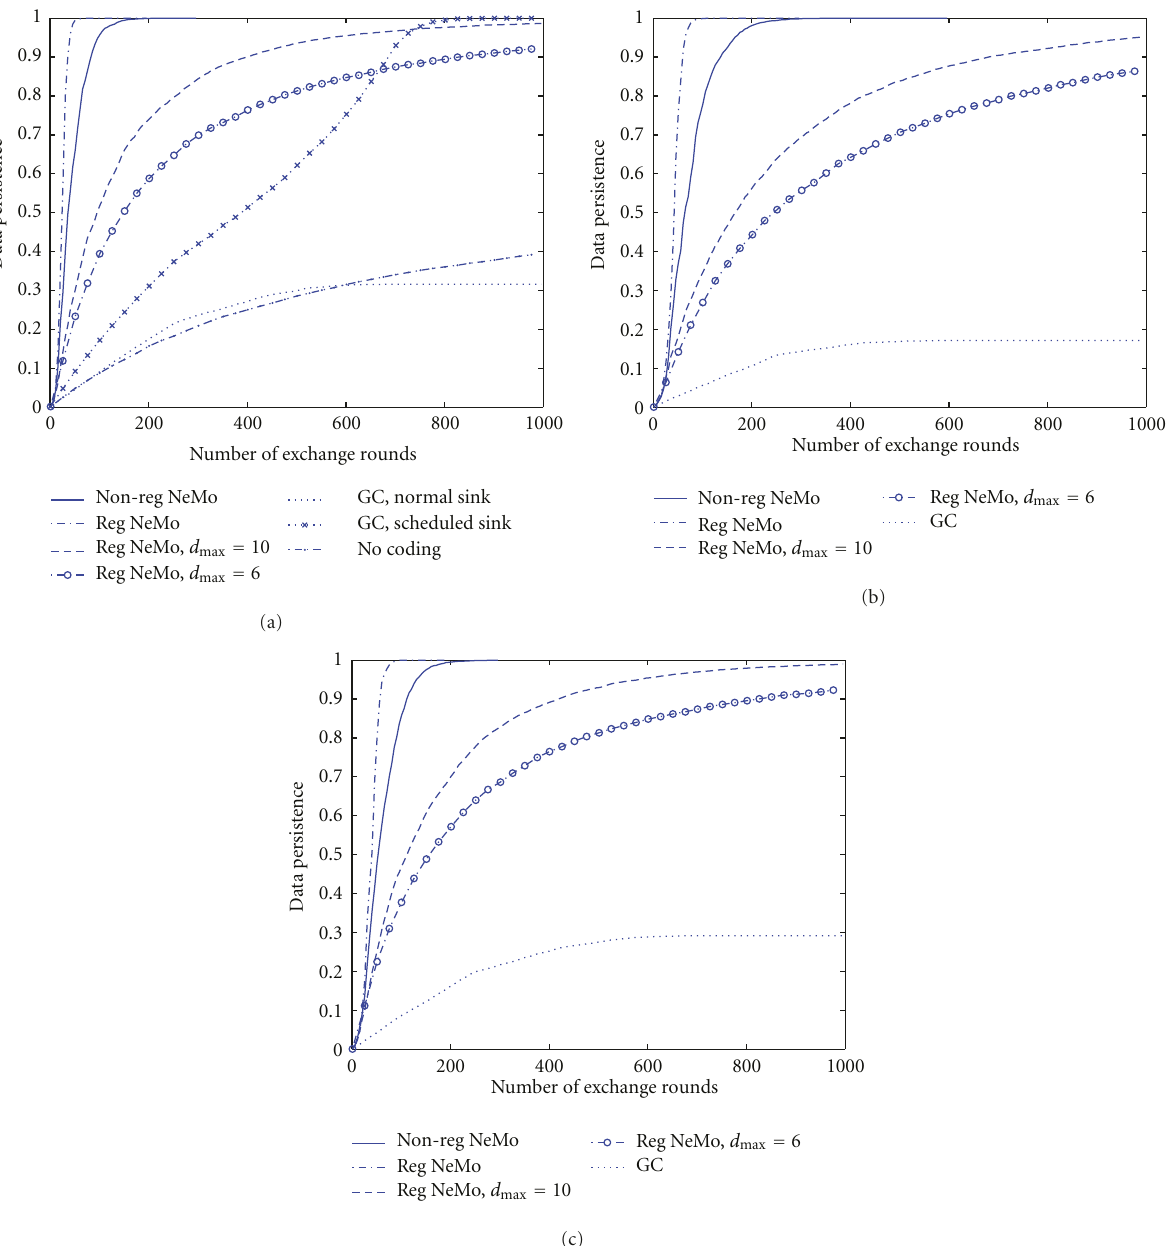
Figure 5: (a) Collisions are resolved at every node; (b) collisions happen at every node; (c) collisions happen at nodes except sink.